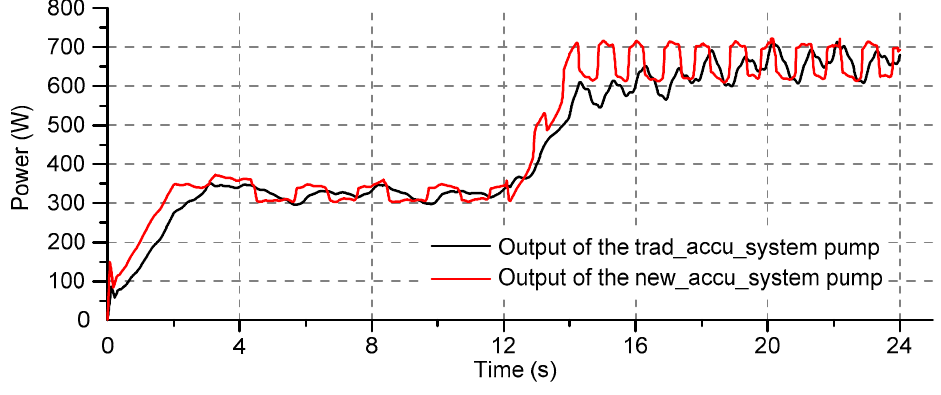
Figure 13. Energy out of the pump in the two systems.